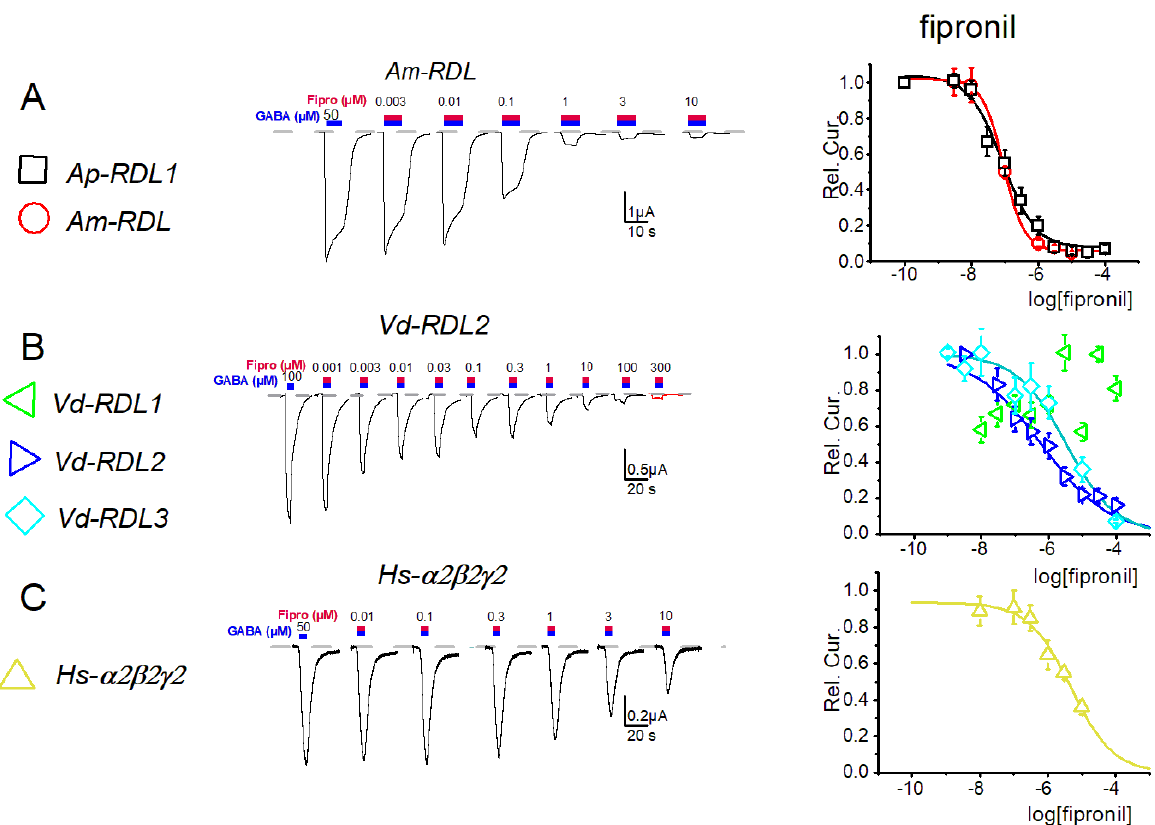
Figure 4. Dose–response curves for fipronil obtained for the seven GABA-A receptors: RDL from A. Pisum and A. mellifera ( A ) RDL1, RDL2 and RDL3 from V. destructor ( B ), and α 2 β 2 γ 2 and α 4 β 2 γ 2 GABA-A receptors from H. sapiens ( C ). ( Left ), exemplar current traces from 1 type of receptor, ( Right ), full dose–response curves. The IC 50 are summarized in Supplementary Table S1.